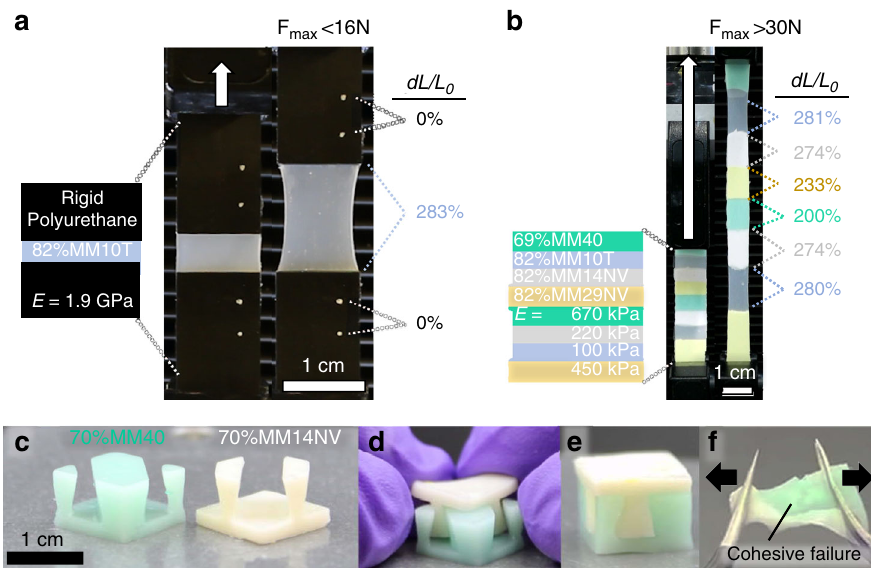
Fig. 4 Multi-material assembly of SilDNs for programmed mechanical gradients. a A photocured 82%MM10T ( E 100% = 100 kPa) block is attached to rigid polyurethane segments to form a tensile coupon (3 mm thick) with a steep modulus gradient. When loaded, the strain is localized entirely to the soft SilDN section (calculated visually, white dots added for tracking). The concentration of stress at the interface causes failure prior to reaching 16 N of applied force. b SilDNs are combined post photocure to form a tensile coupon with a shallow modulus gradient. The relative strain of each segment is inversely proportional to the stiffness of the SilDN component. The smooth gradient allows this coupon to sustain a load in excess of 30 N. c A pair of objects containing complementary tapered features (dovetails) printed from different SilDN materials. d Aligning the compliant green bodies to form a mechanical interlock. e The assembly after fully curing the SilDN components shows f , cohesive failure during destructive